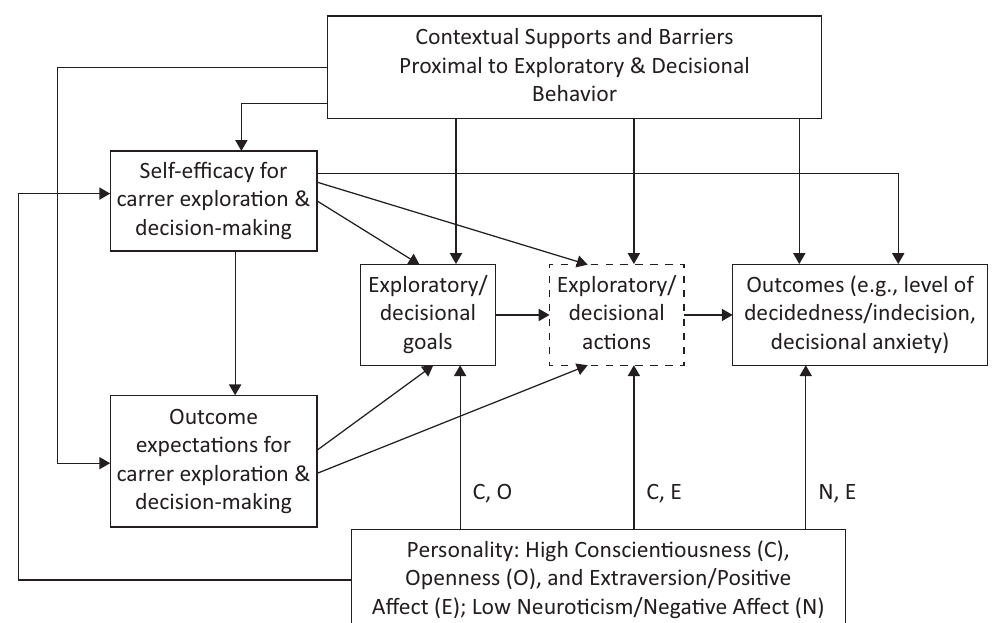
Figure 1. Model of career self-management adapted from Ireland and Lent (2018, p. 38). Reprinted with